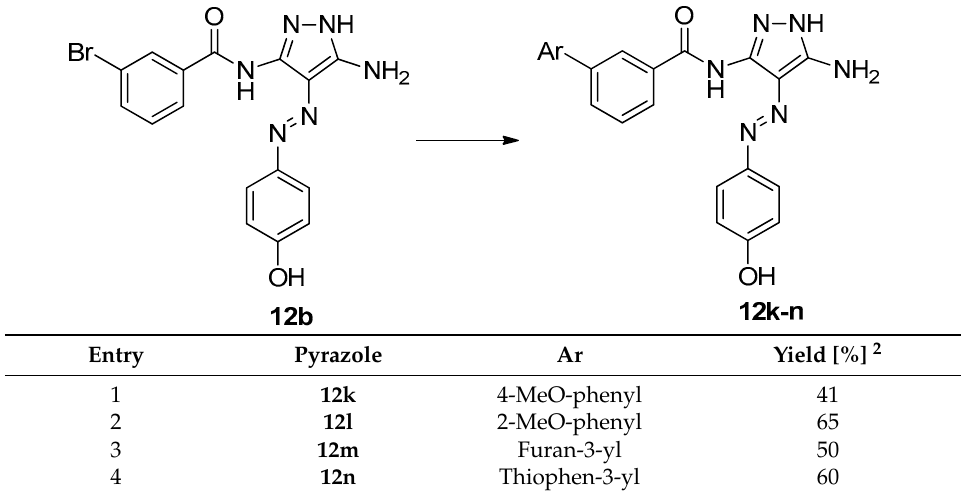
Table 3. Arylation of pyrazole 12b by Suzuki-Miyaura coupling 1 .